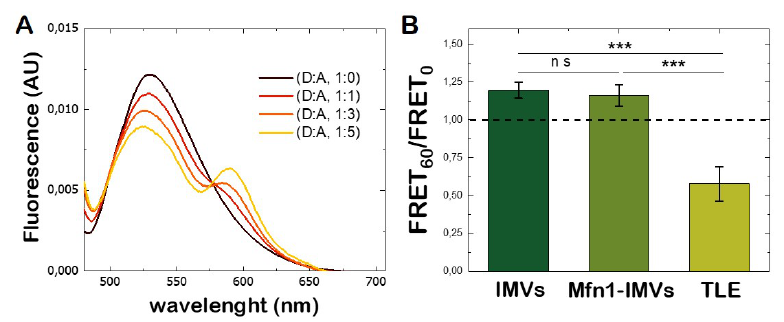
Figure 2. Total lipid mixing assay of inner membrane vesicles (IMVs). ( A ) Fluorescence emission spectra of IMVs labelled with NBD-PC (donor, D) and RhoPE (acceptor, A) at a different molar ratios. The excitation wavelength was 460 nm. The peaks at 523 and 593 nm correspond to the maximum fluorescence emission of the donor and acceptor respectively. An optimal Förster resonance energy transfer (FRET) from NBD to Rhodamine was observed at molar ratios of 1:5 between the donor and the acceptor. ( B ) FRET efficiency ratio of IMVs (left), Mfn1-IMVs (middle) and E. coli total lipid extract (TLE) large unilamellar vesicles (LUVs) (right), before and after 60 min incubation with 10 mM GTP. Student’s t -test was performed to measure the significance of statistical difference between the different groups. p ≤ 0.05, ( ∗ ) and p ≤ 0.001, ( ∗ ∗ ∗ ) were considered statistically